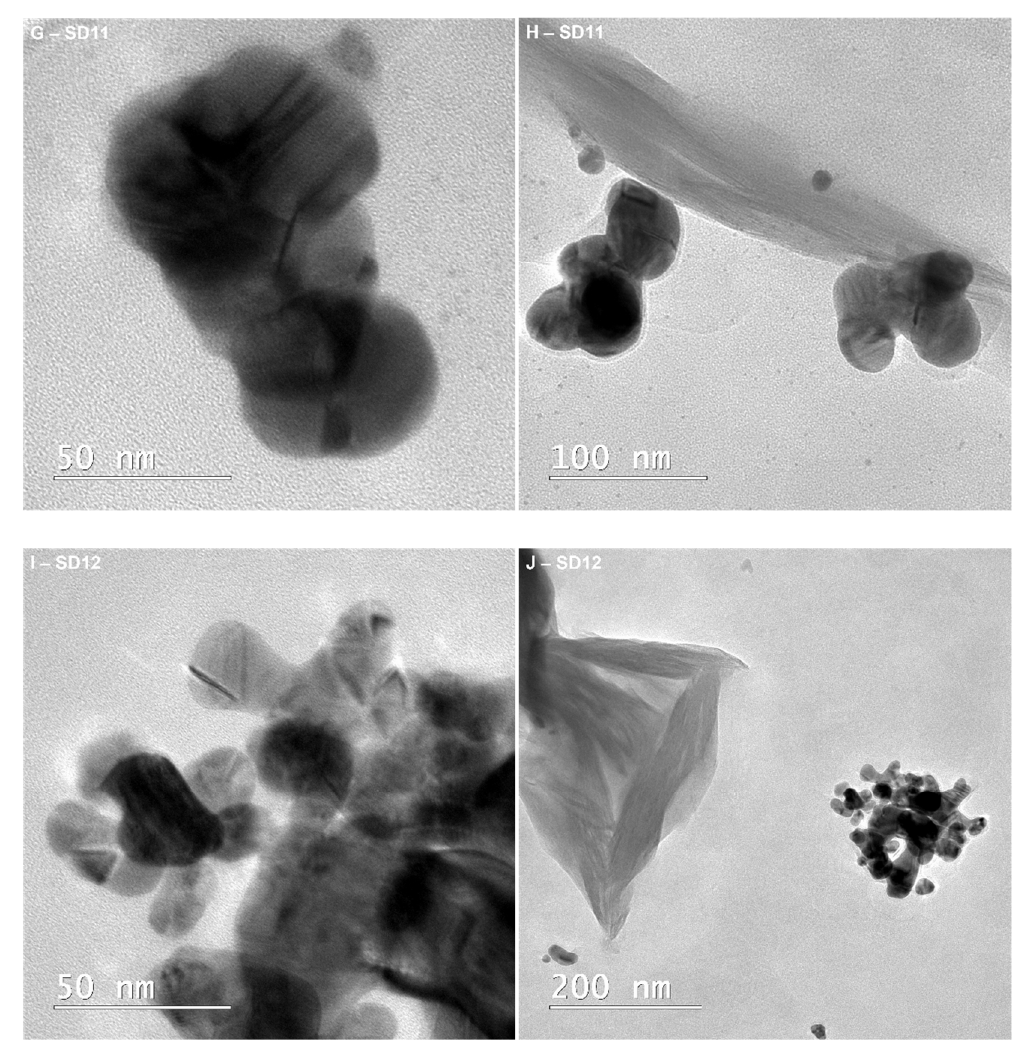
Figure 1. TEM image of bentonite-supported metal nanoparticles employed in the decontamination solutions: ( a,b ) SD5-mag 100,000X, mag 50,000X; ( c , d ) SD6-mag 180,000X, mag 50,000X; ( e , f ) SD10-mag 180,000X, mag 50,000X; ( g , h ) SD11- mag 180,000X, mag 60,000X; ( i , j ) SD12-mag 180,000X, mag 29,000X.